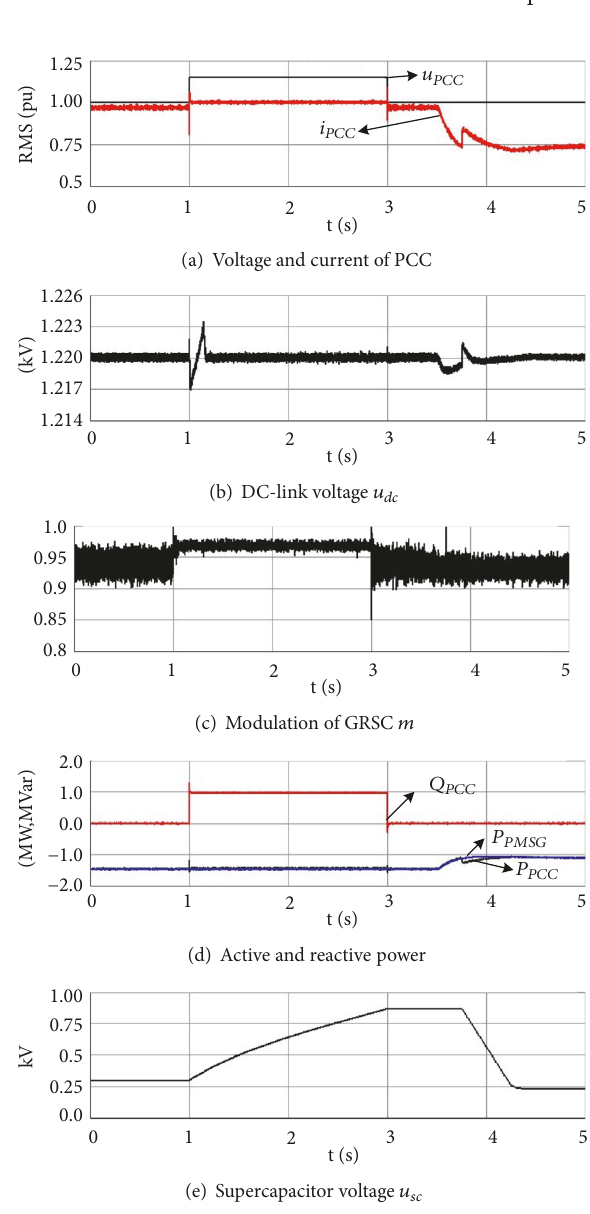
Figure 6: Response of GRSC with SCESU under voltage swell to